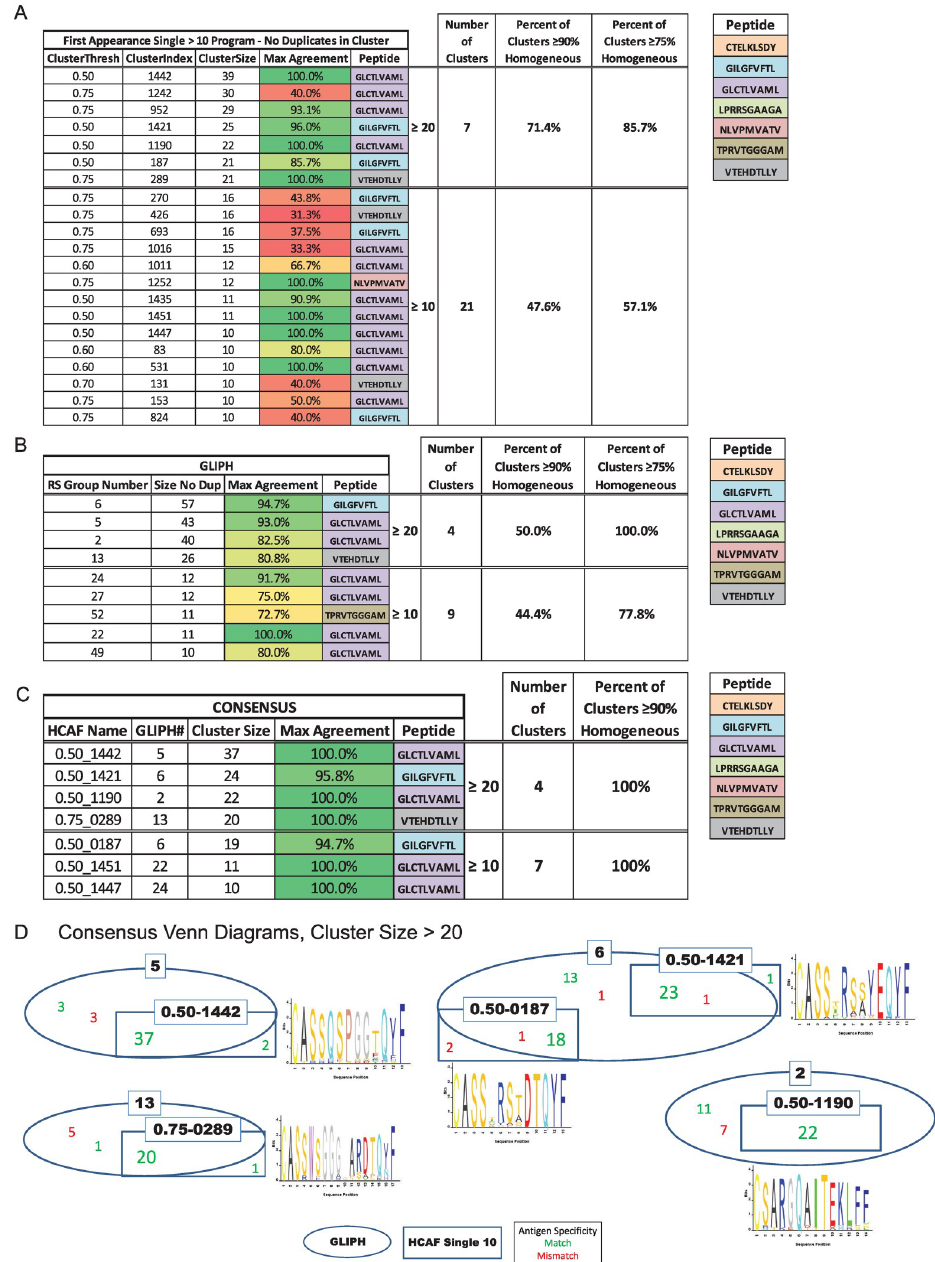
Fig 4. Comparison of GLIPH and HCAF methods to identify correct antigen specificity groups. TCR β sequences of known antigen specificity were analyzed for peptide specificity using Hierarchical Clustering Appearing First (HCAF) (A) and GLIPH (B). (A, B) Clusters � 10 or 20 unique sequences in size were assessed for their ability to group TCRs recognizing the same peptide. The data show the size of each cluster and the percentage of sequences in that cluster that bind the same peptide (max agreement). Homogeneity of the clusters for a single peptide is indicated by the percent of clusters that achieve > 75% or 90% homogeneity for the same peptide sequence. (C) Consensus clusters indicate clusters of TCR CDR3 β sequences that were shared by antigen specificity groups generated by both GLIPH and HCAF. Tables show consensus cluster origin and size, and each consensus cluster was assessed as described above for the percentage of sequences in that cluster that recognize the same peptide (max agreement). This is also presented as the percent of consensus clusters that reach 75% and 90% homogeneity for a single peptide. ( D ) Representative diagrams of consensus clusters outlined in (C). Oval represents sequences found in GLIPH cluster and rectangle represents sequences found in the HCAF cluster. Where the oval and rectangle overlap is the consensus cluster. Green numbers indicate the number of sequences that match the correct peptide and red those sequences that